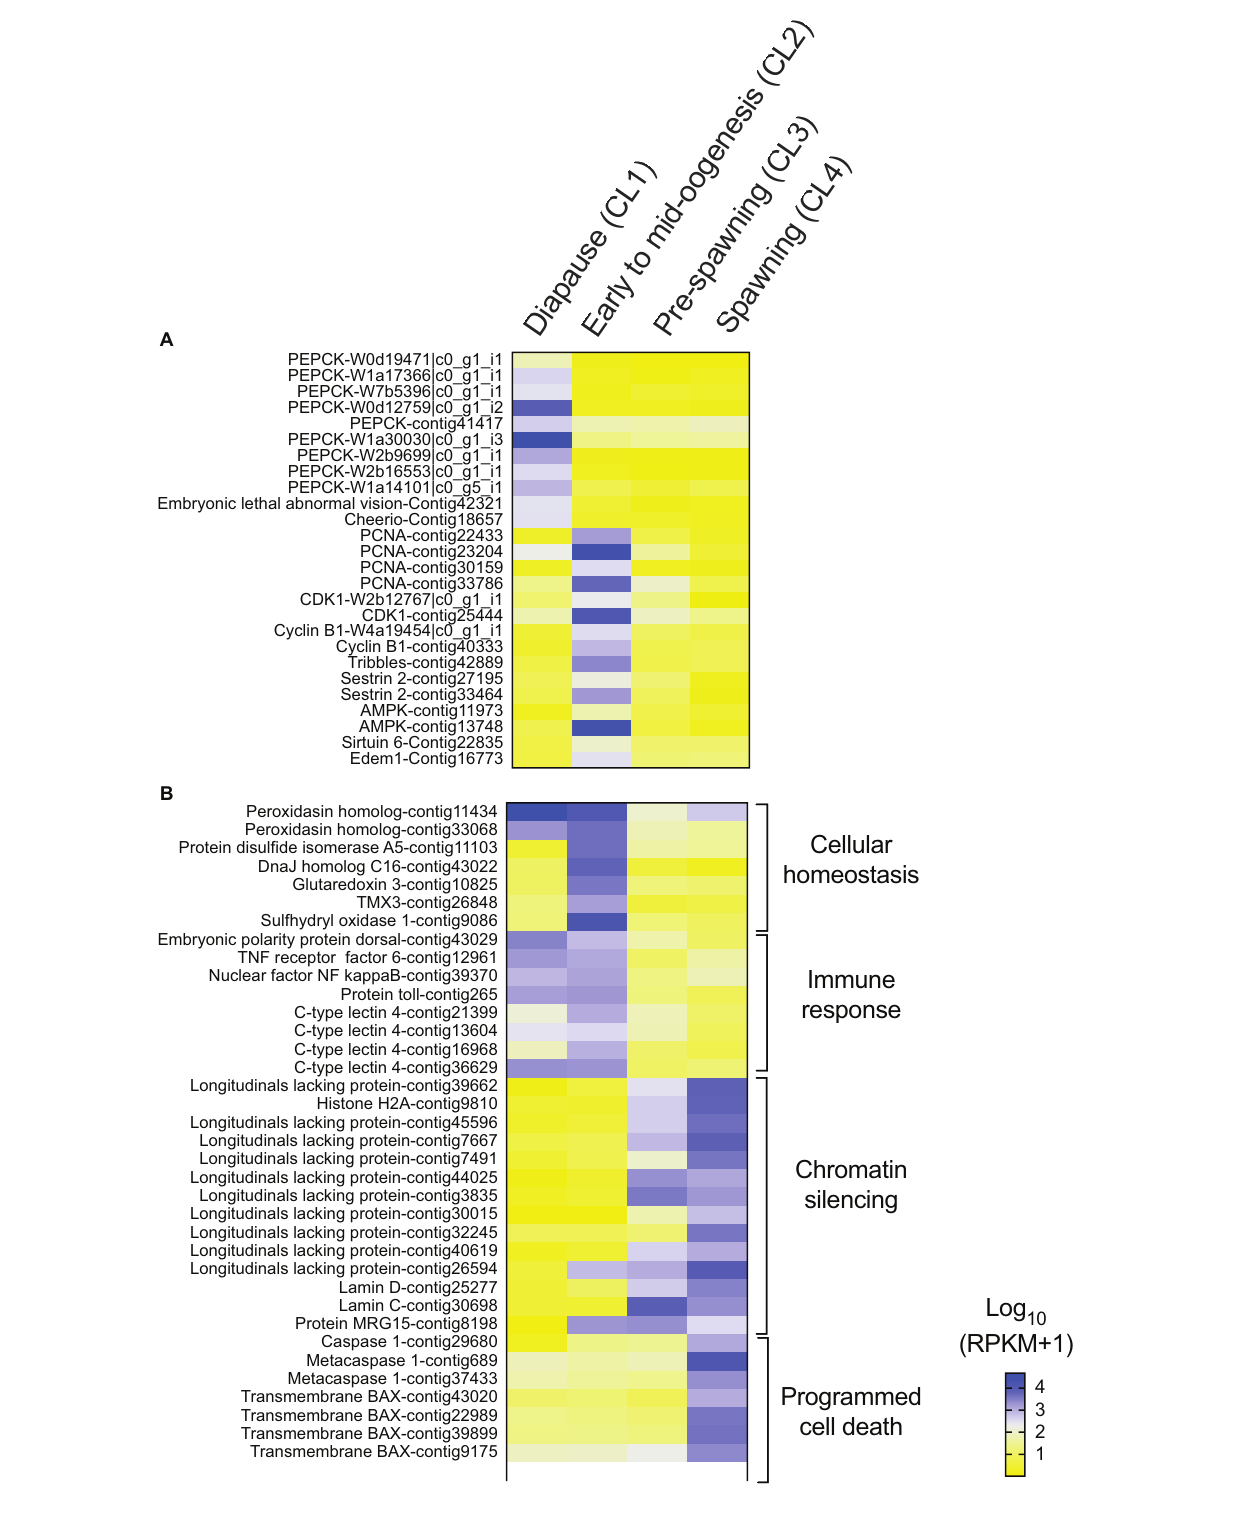
Frontiers in Marine Science |